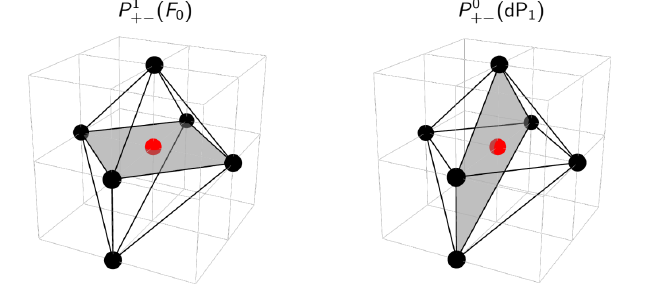
( F ) is the same as P 0 0 + −